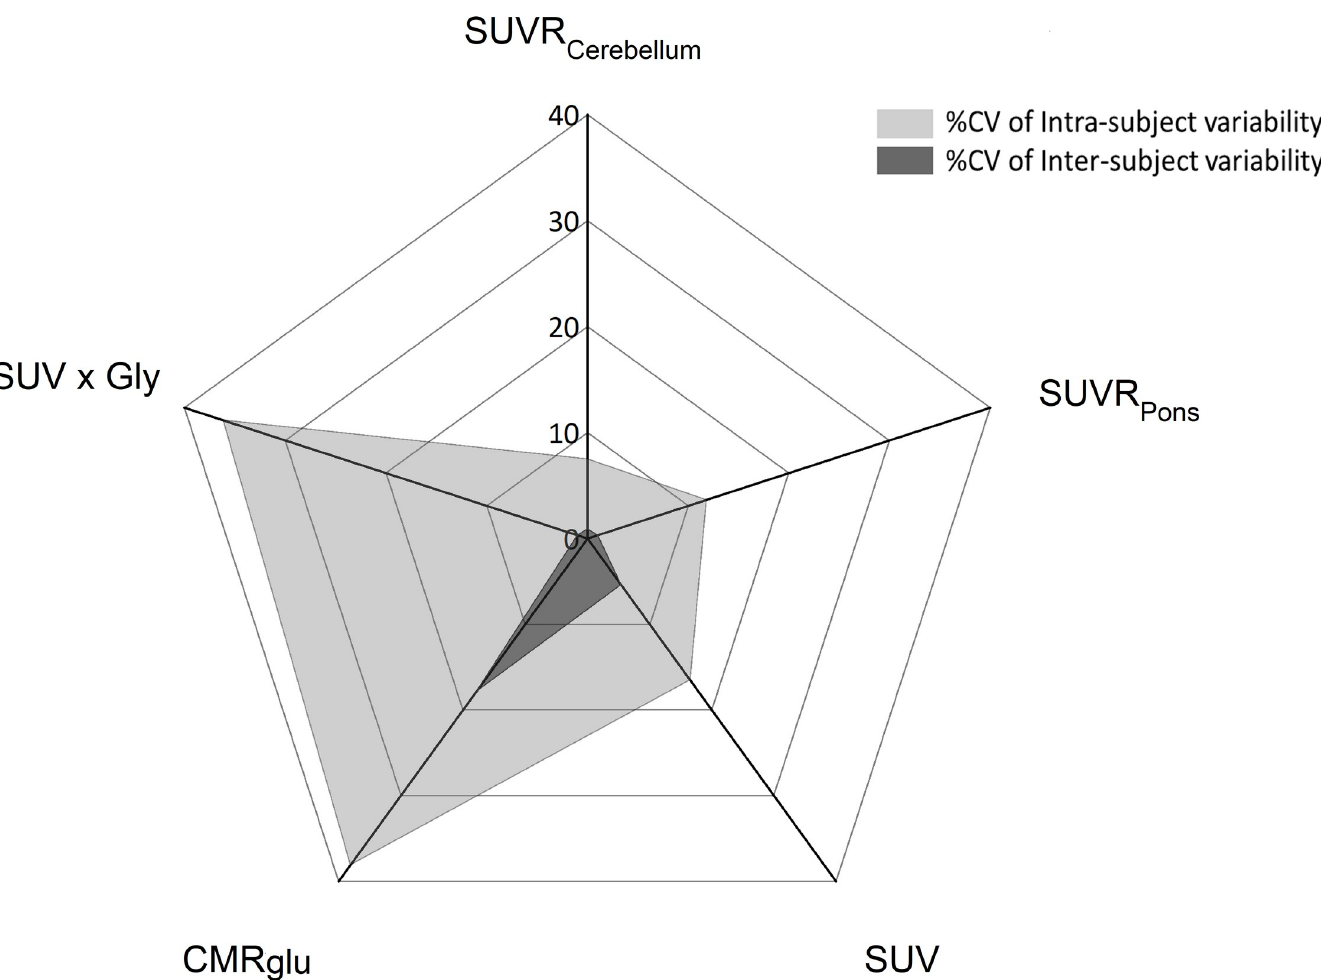
Fig 1. Mean intra- (n = 6) and inter-variabilities (n = 6) (expressed in CV%) of all [ 18 F]FDG outcome parameters in the putaminal region.